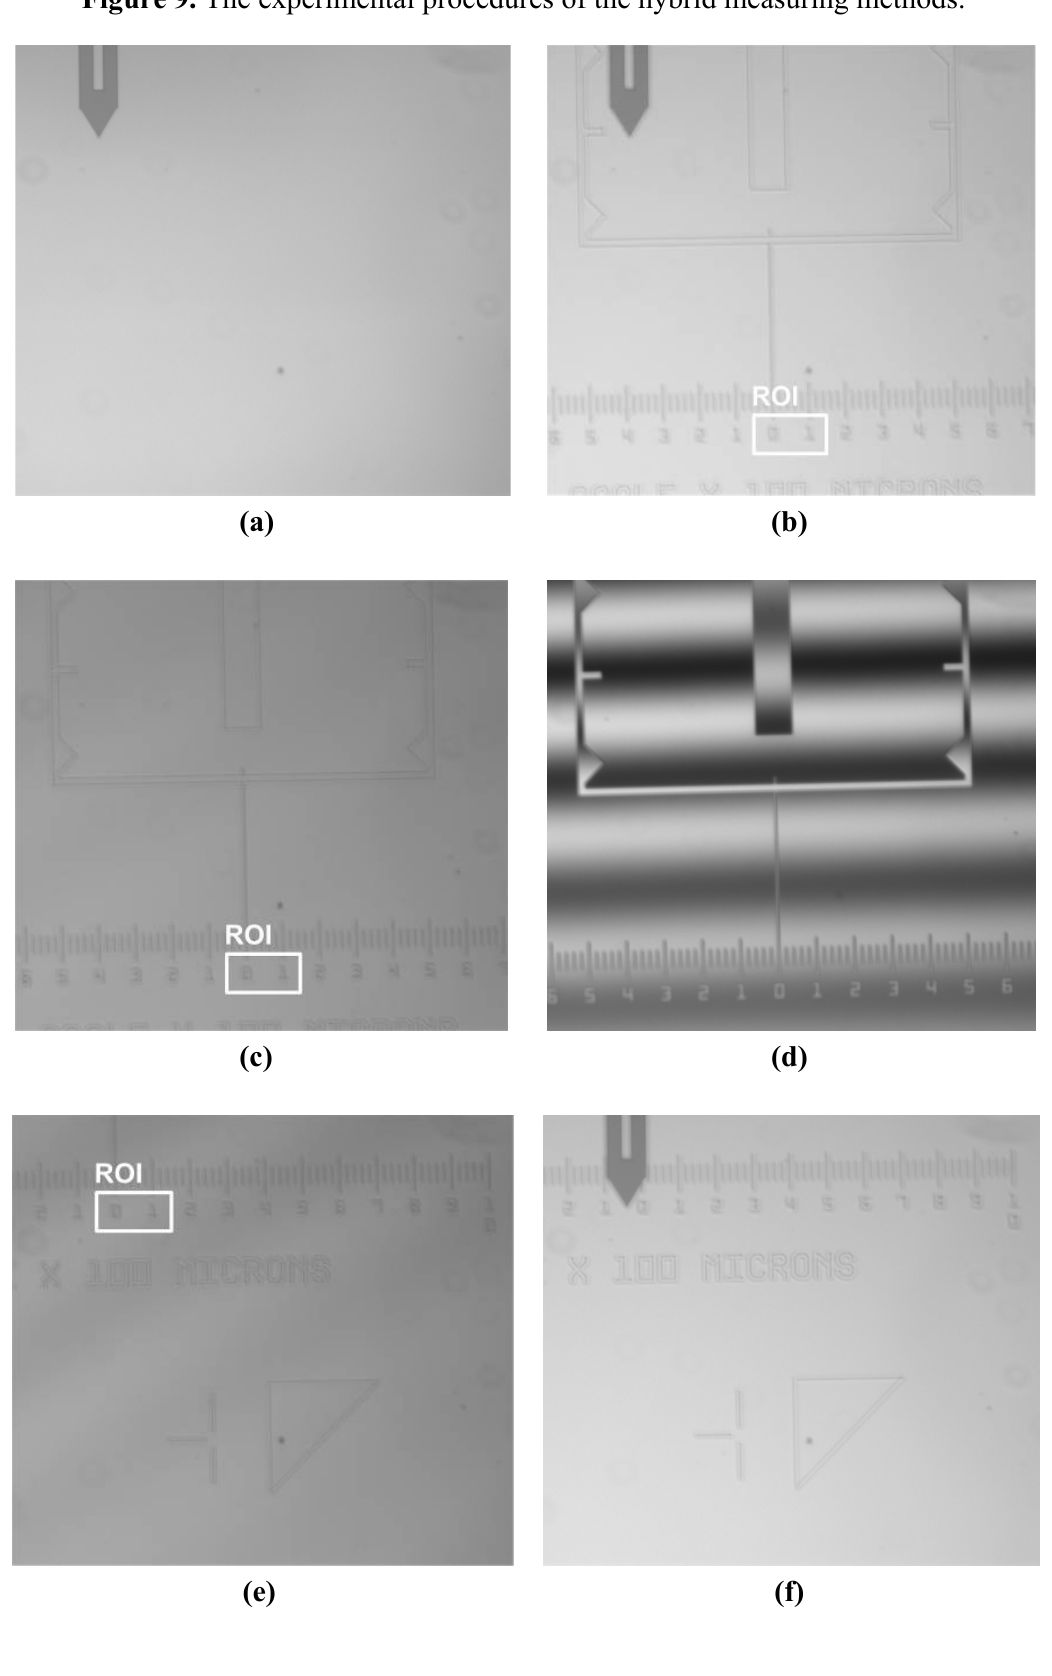
Figure 9. The experimental procedures of the hybrid measuring